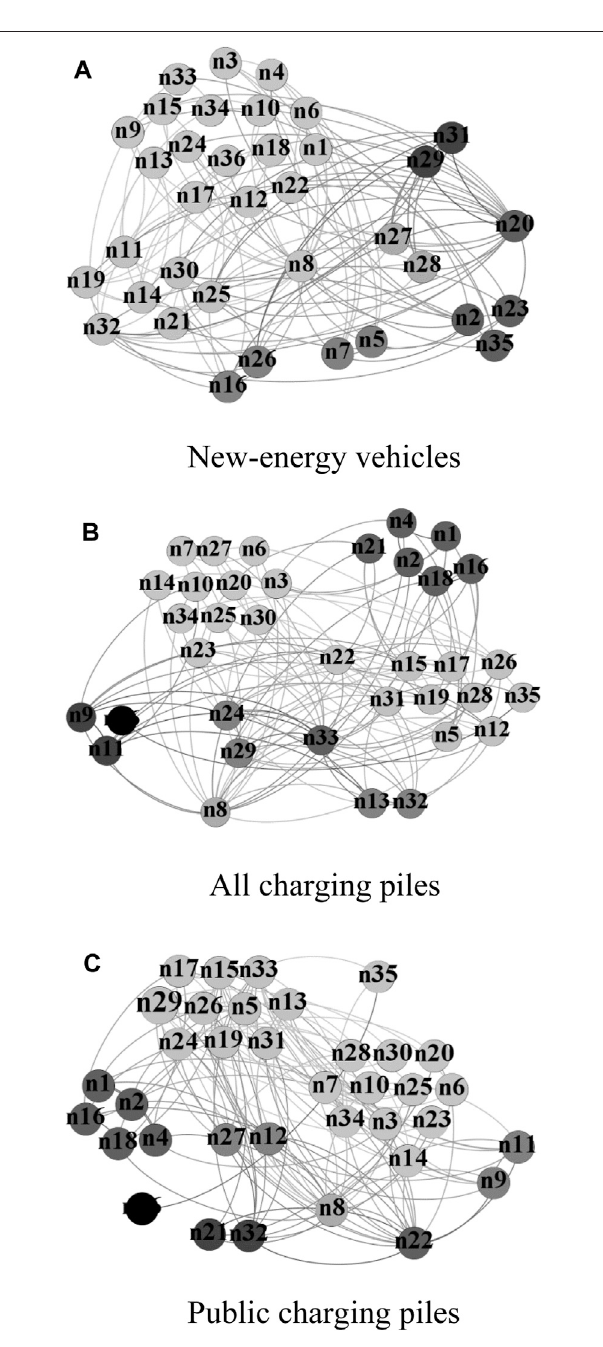
FIGURE 5 | Clustering of the three networks (where n1 to n36 represent individual months from May 2016 to April 2019).